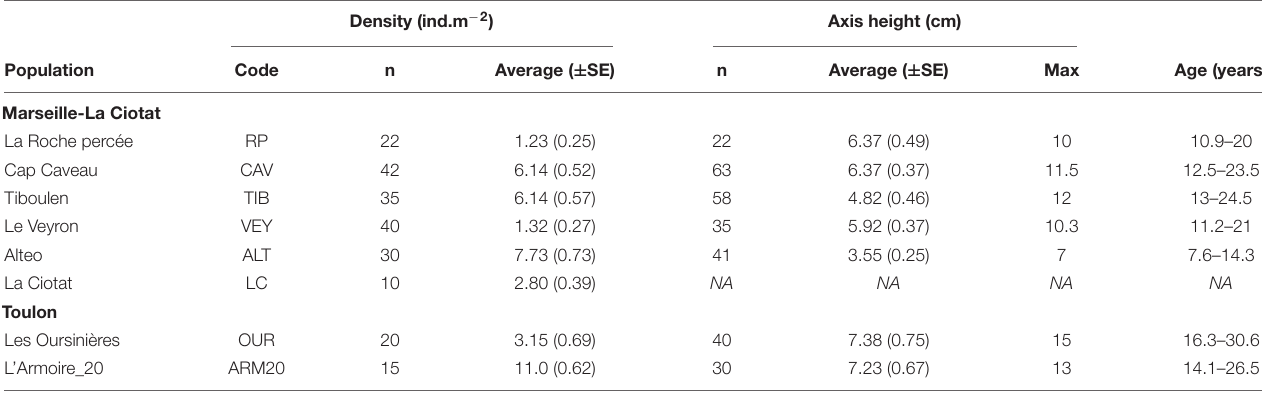
TABLE 2 | Demographic structure of Ericaria zosteroides with the density of populations (n, number of quadrats per site; average, average density, and SE), the size of individuals (n, number of individuals; average, average with SE; and Max, maximum size of the main axis), and age: estimate range of the age of individuals according to a growth rate estimation for the axis of 0.5 to 0.9 cm.year − 1